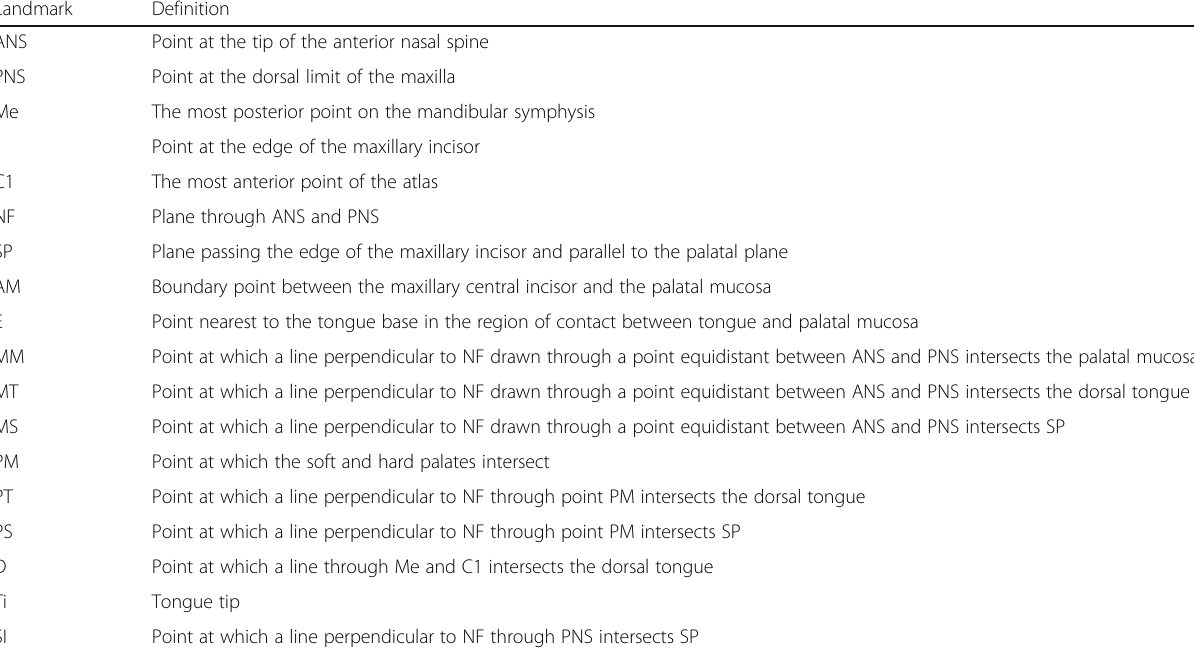
Table 1 Reference points and planes (modified from Fujiki et al. [14])